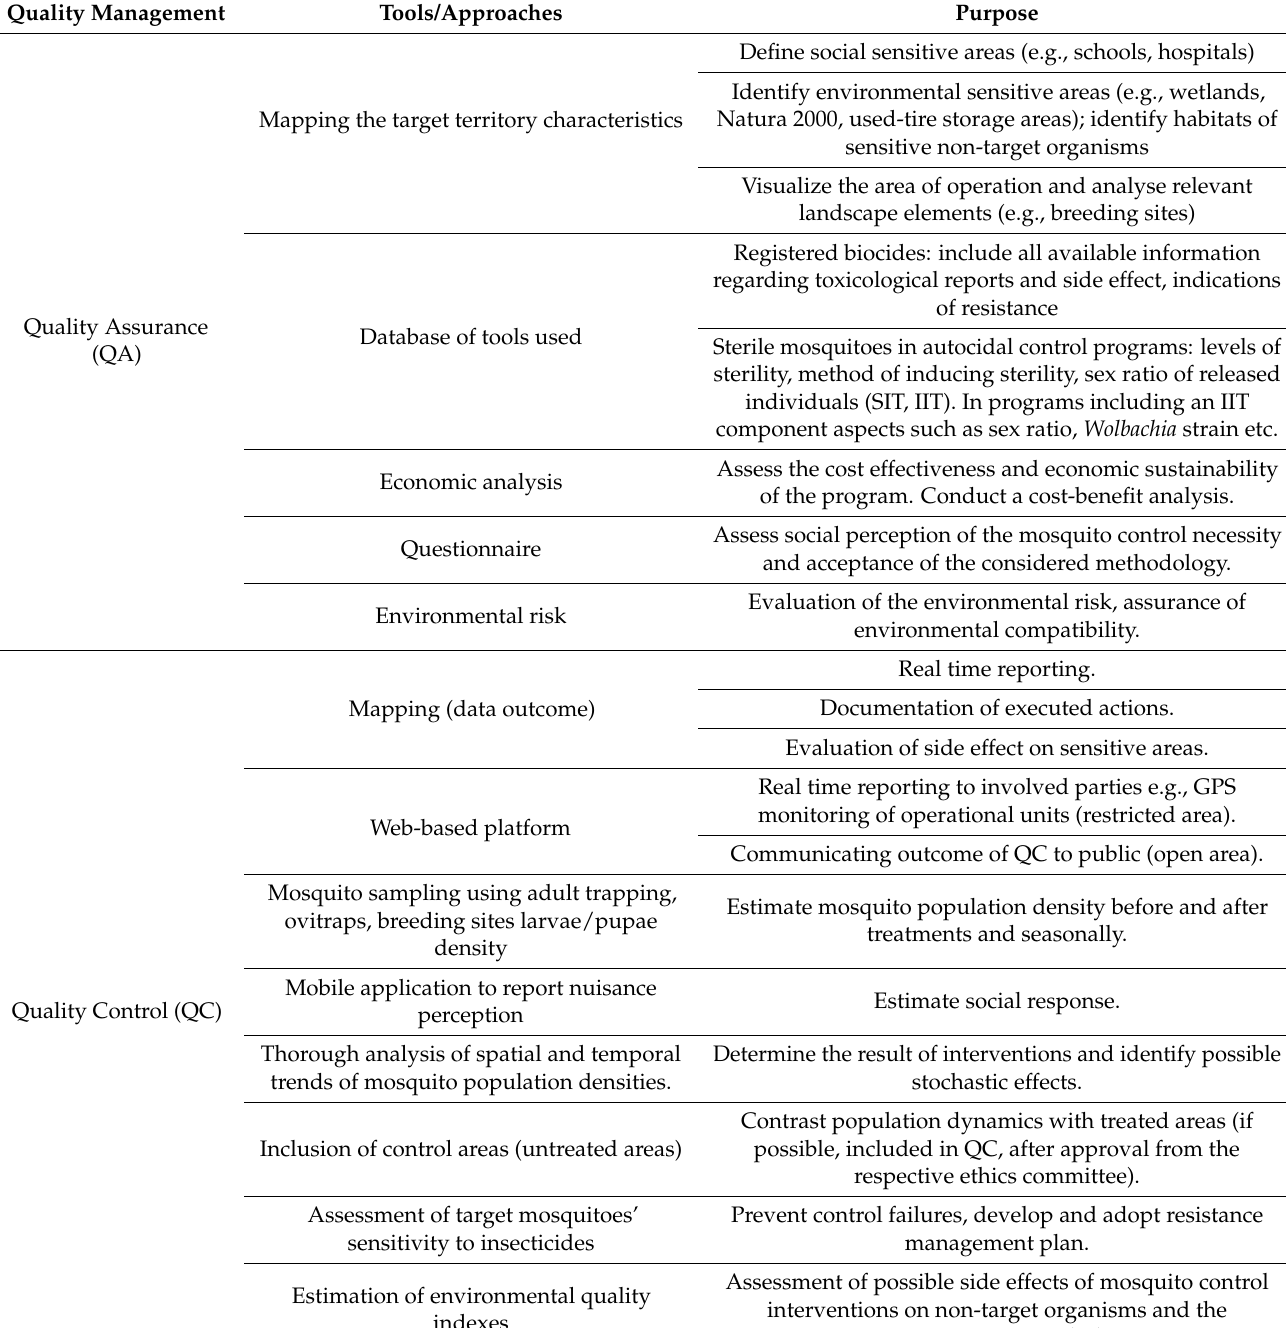
Table 3. Tools and approaches for implementing a QM system; quality assurance (QA) and quality control (QC). Quality